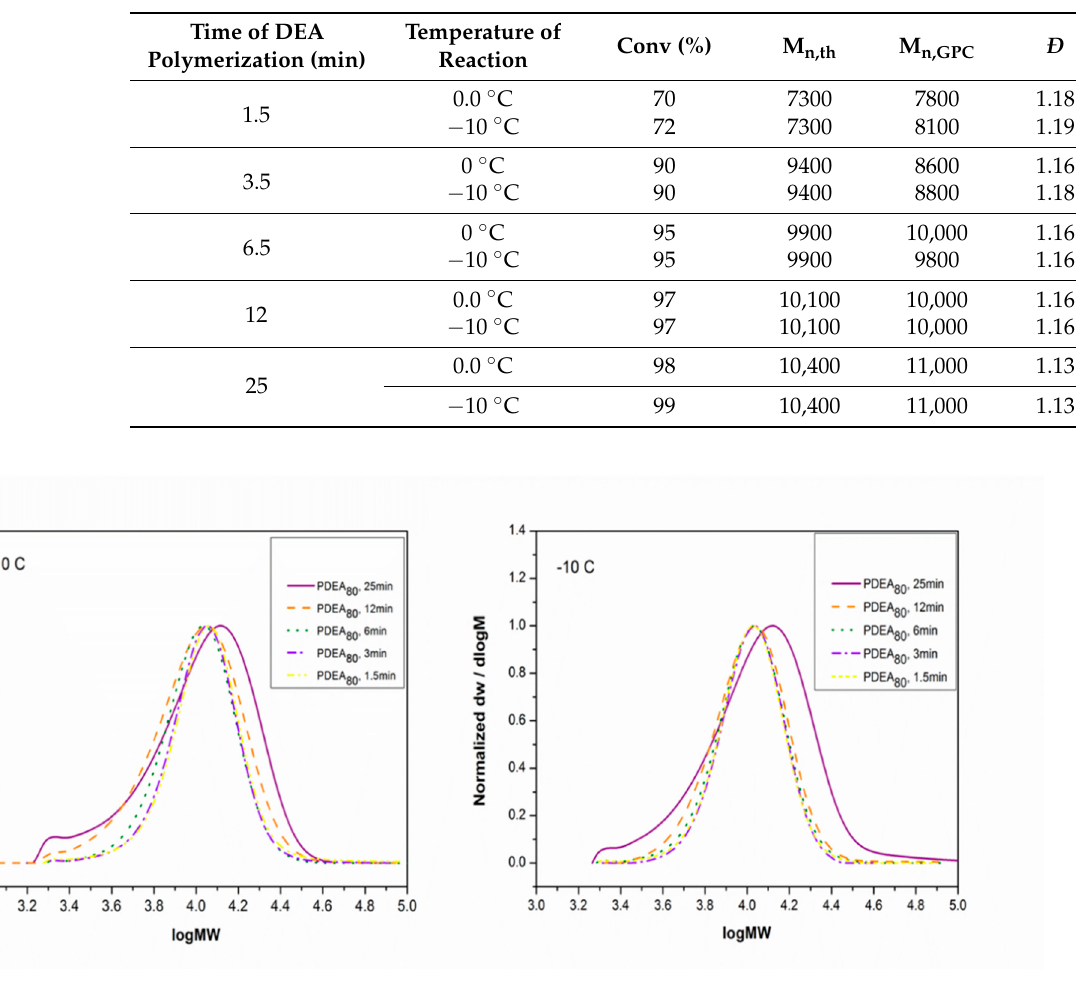
Figure 6. 1 H NMR spectra for Cu(0)-mediated polymerization of DEA in H 2 O at 0.0 °C and − 10 °C